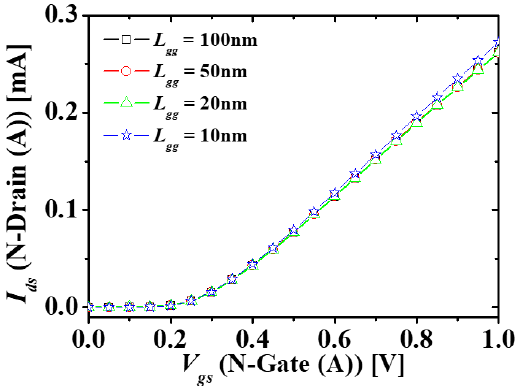
Figure 4. I ds - V gs characteristics of N-type (A) MOSFET in M3DNOR at different L gg s.